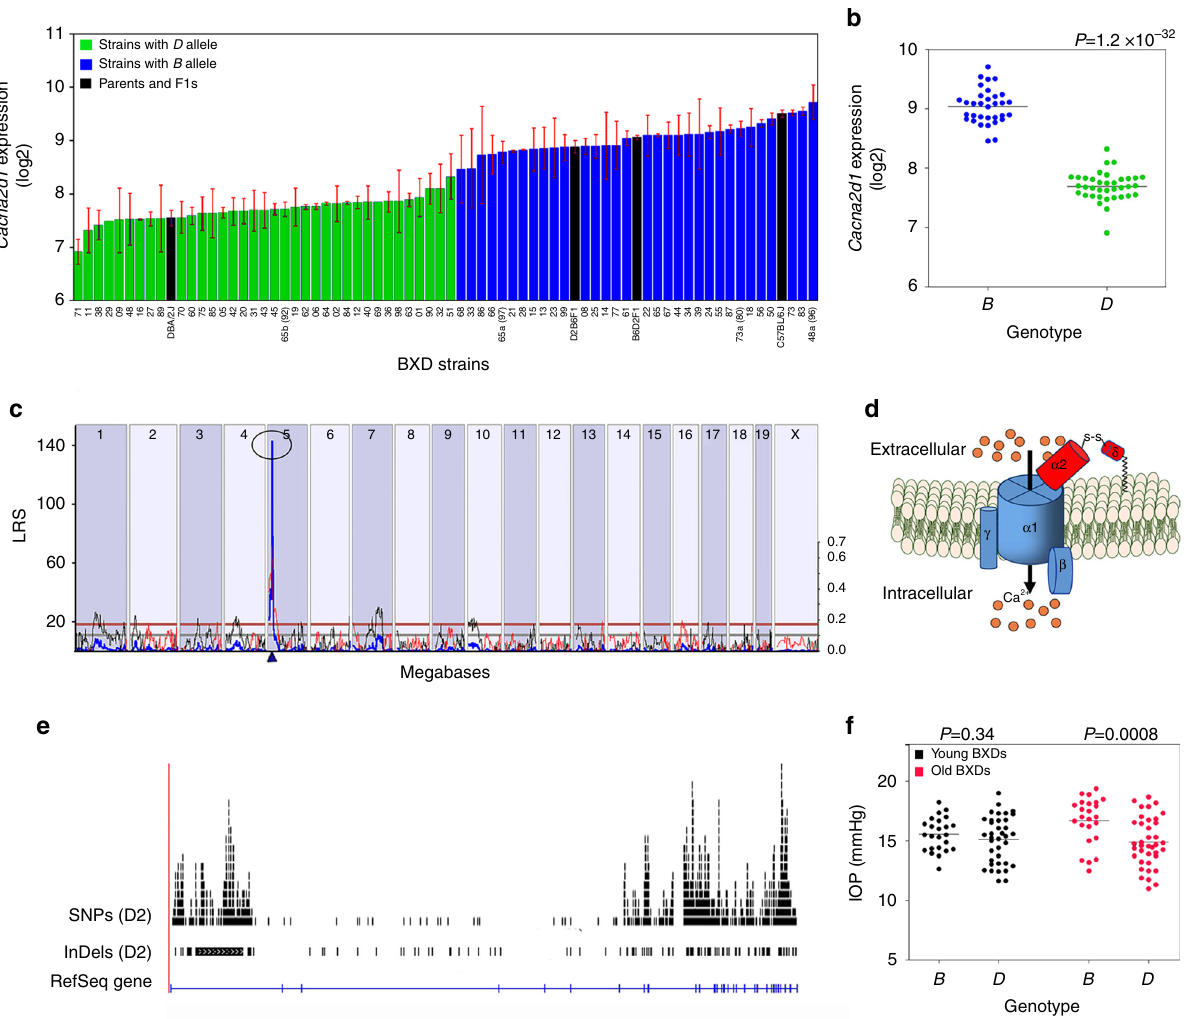
Fig. 3 Association analyses of Cacna2d1 haplotype variants. a Cacna2d1 expression in the whole eye varies across BXD strains. The bars depict a range of expression values from 6.9 ± 0.03 and 9.7 ± 0.10 (mean ± SEM). On the Y-axis, Cacna2d1 expression is on a log 2 scale. Parental strains (black), F1s (black), D parental allele Cacna2d1 (green), and B parental allele of Cacna2d1 (red) are on X-axis. b Cacna2d1 haplotype in fl uences Cacna2d1 expression level in eyes of BXD strains. BXD strains with the D parental allele have lower expression of Cacna2d1 in the eye, while those with the B parental allele have higher expression of the gene ( n = 70; P < 0.0001). P -value was calculated using an ANOVA. c Genetic mapping revealed a single highly signi fi cant cis -eQTL for Cacna2d1 on Chr 5. The purple triangle indicates the location of Cacna2d1 within the mouse genome. d Subunit assembly of voltage-gated calcium channels. Graphic representation of the high voltage-activated calcium channel complex consisting of the main pore forming α 1 (blue) subunit plus ancillary, β (blue), γ (blue), and α δ α δ δ 2 (red) and 1 (red) subunits. 2 and 1 subunits have a disulphide bond between them. The 1 unit is GPI-anchored to the plasma membrane. e UCSC Genome Browser illustration of gene structure, and location of SNPs and InDels in Cacna2d1 on Chr 5 of the mouse genome. Reference Sequence mRNA is represented in blue. f Effect of Cacna2d1 haplotype on IOP is age-dependent. In this scatter plot, parental allele of Cacna2d1 does not signi fi cantly in fl uence IOP in young BXDs ( P = 0.34, n = 63, age = 1 – 2.1 months; left). In contrast, BXD strains carrying the B parental allele of Cacna2d1 have higher IOP, while those with the D parental allele have lower IOP in older mice ( P = 0.0008, n = 64, age = 9.1 – 13 months; right). P -value was calculated using an ANOVA. F1s were not included in these signi fi cant association for these eight SNPs was not found in the IOP metadata, possibly due to different genetic effects in the multiple ethnicities included in that study.